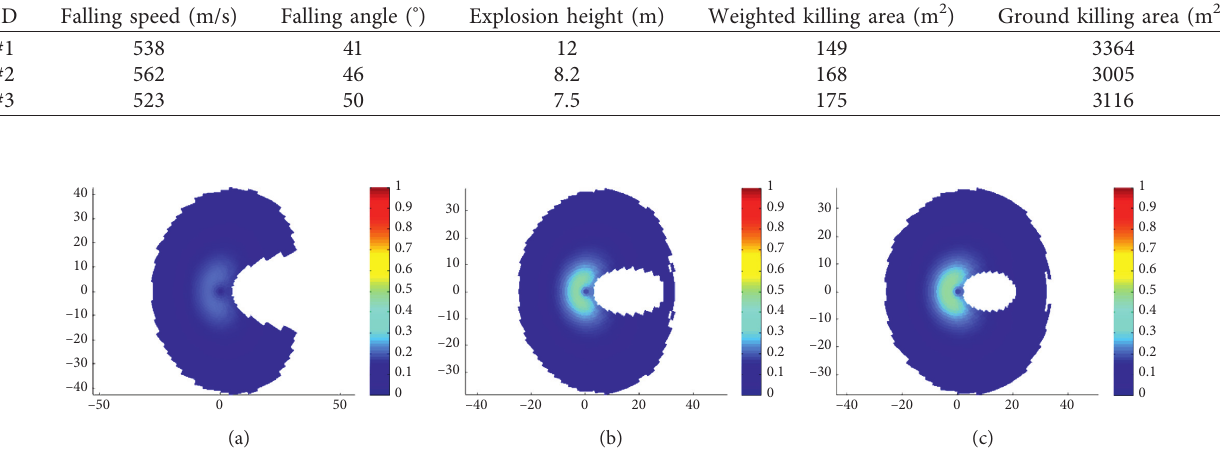
Figure 9: Ground damage distribution of warhead: (a) witness board #1, (b) witness board #2, and (c) witness board #3.